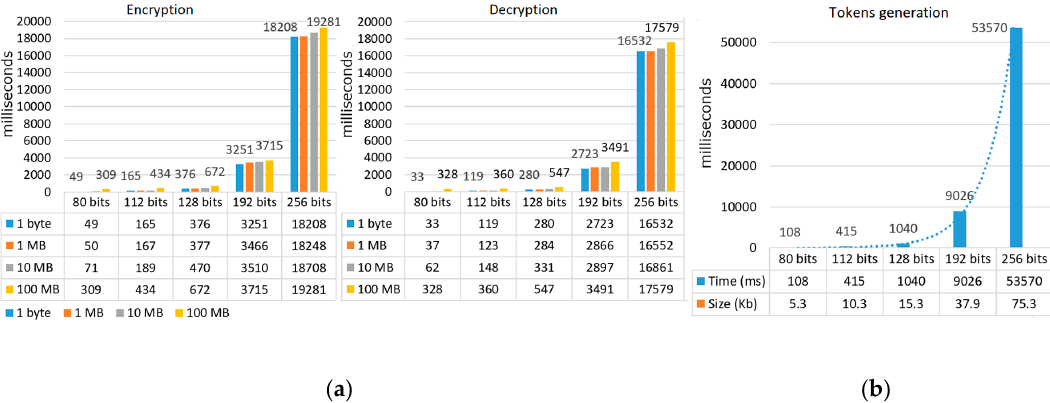
Figure 17. ( a ) Performance of encryption, decryption ( b ) Performance of tokens generation on the y-axis in milliseconds.